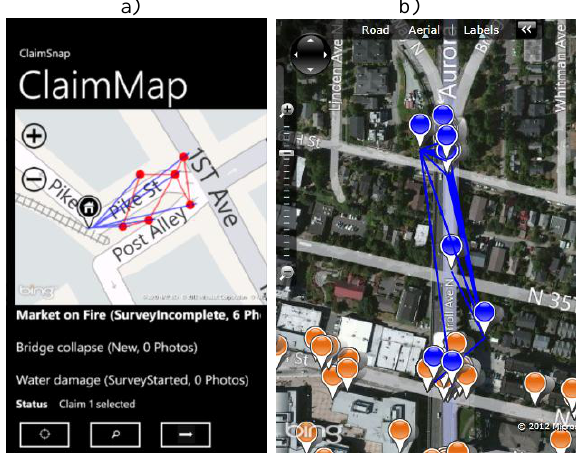
Figure 12 a) Graph of Matching Photographs on Mobile Client and b) on Desktop Silverlight™ Client